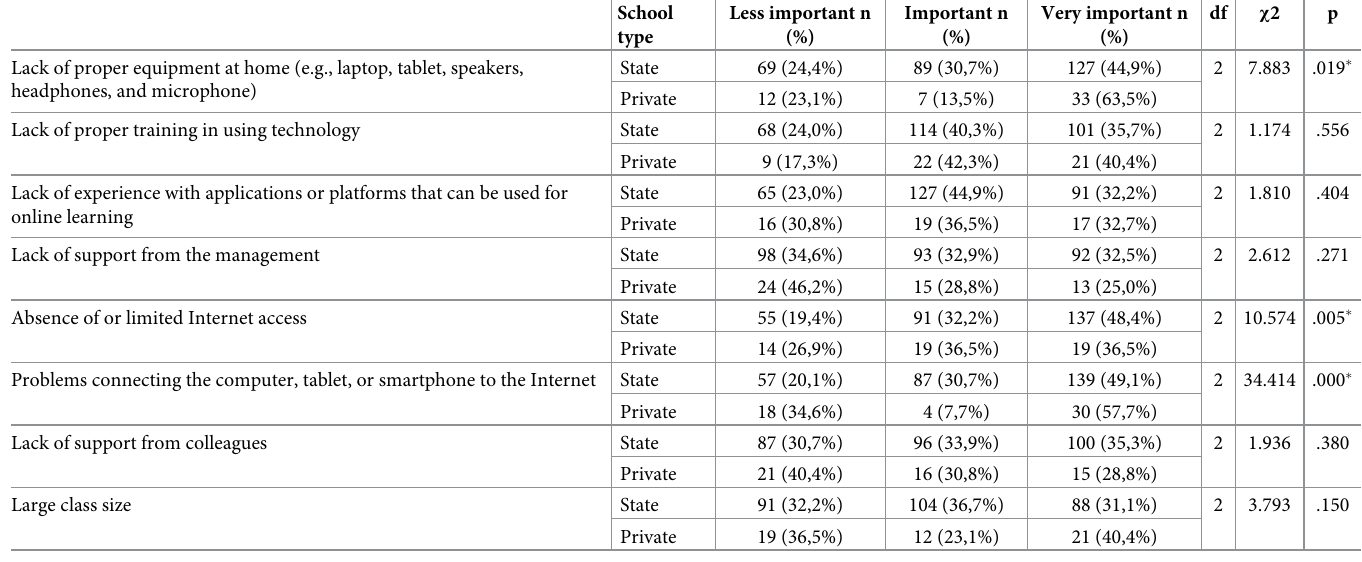
Table 3. Pets’ opinions on the difficulties of online physical education teaching by school type.